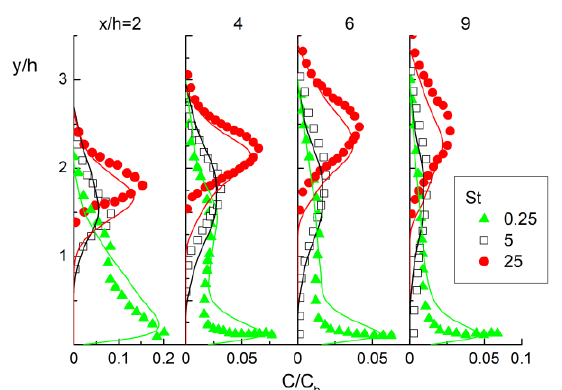
Figure 14. The transverse profiles of particle concentrations for various Stokes numbers, St + , after a 2D obstacle. The points are LES calculations [10]; the lines are the authors’ predictions.